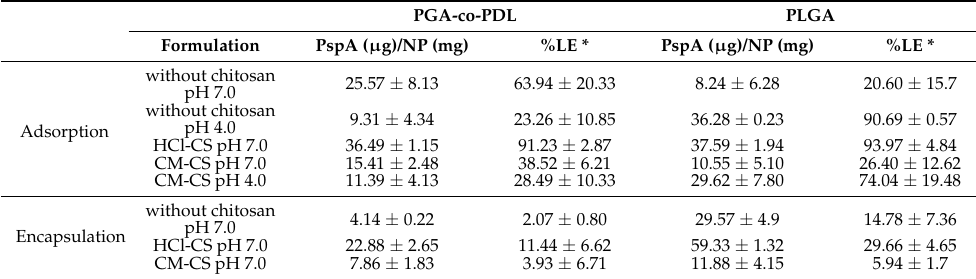
Table 4. Effect of pH and chitosan type on PspA4Pro adsorption and encapsulation into PGA-co-PDL and PLGA hybrid NPs prepared by single ( o / w ) or double ( w / o / w ) emulsion solvent evaporation method (mean ± SD, n =